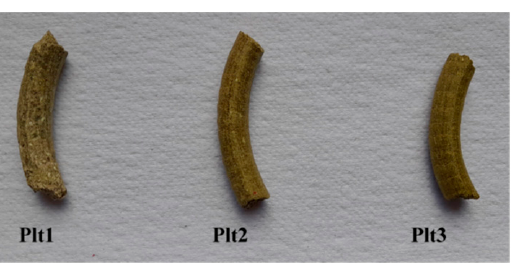
Figure 4. The appearance of three types of pellets composed of seaweed, hay, and sawdust. Figure 5 compares the appearances of Plt4, Plt5, Plt6, Plt7, and Plt8. These pellets differed in seaweed content. Plt8 was composed of 100% seaweed. This pellet was darker and shinier than the other types because raw seaweed is much darker than wood chips. Moreover, lignin in the pelletizing process rises to the surface, and for this reason, pellets look smooth and shiny. Plt4 had 45% wood chip content. Wood particles can clearly be seen on its surface. Wood chips have larger particle sizes than seaweed, sawdust, and hay.